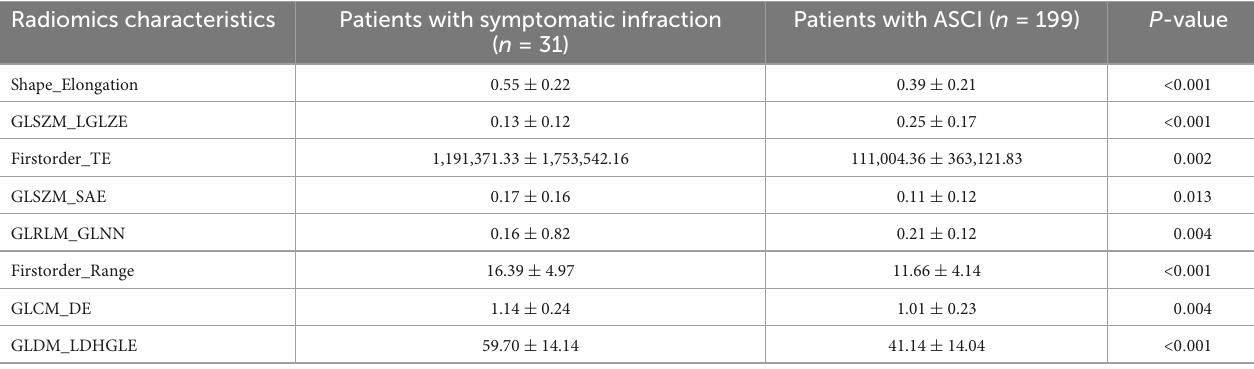
TABLE 2 Comparison of eight selected radiomics features after dimensionality reduction and feature selection using least absolute shrinkage and selection operator (LASSO) regression in patients with symptomatic infarction and ASCI. Radiomics characteristics Patients with symptomatic infraction Patients with ASCI ( n = ( n = 31)